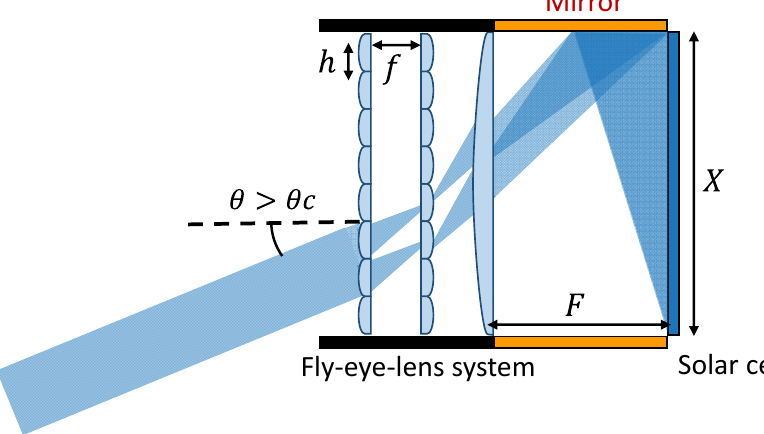
Figure 9. Increase in allowable incident angle with mirrors.